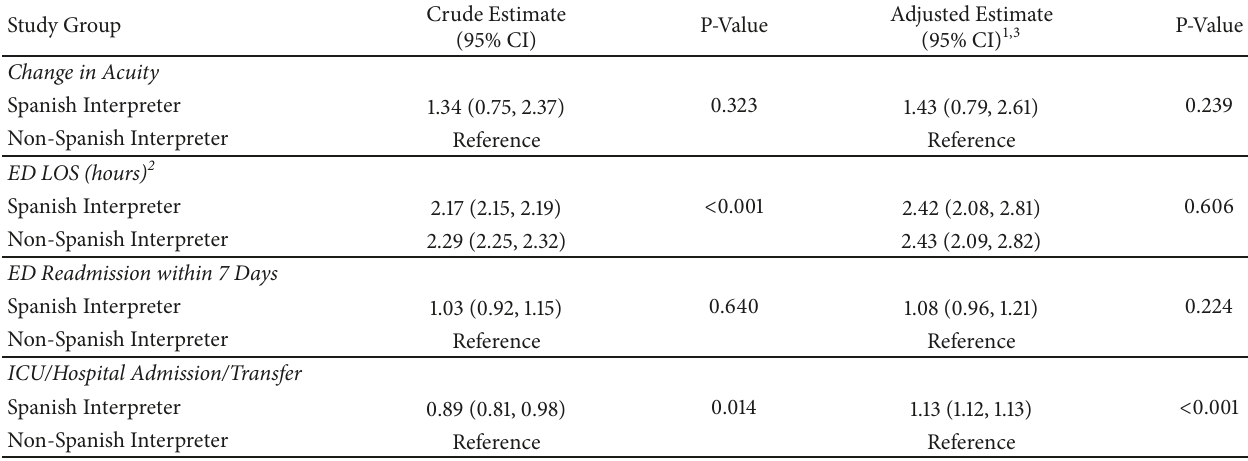
Table 4: Outcome variables by interpreter